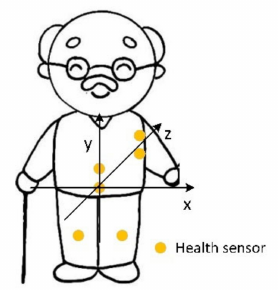
Figure 2. Deployment diagram of the nodes in the WBAN.